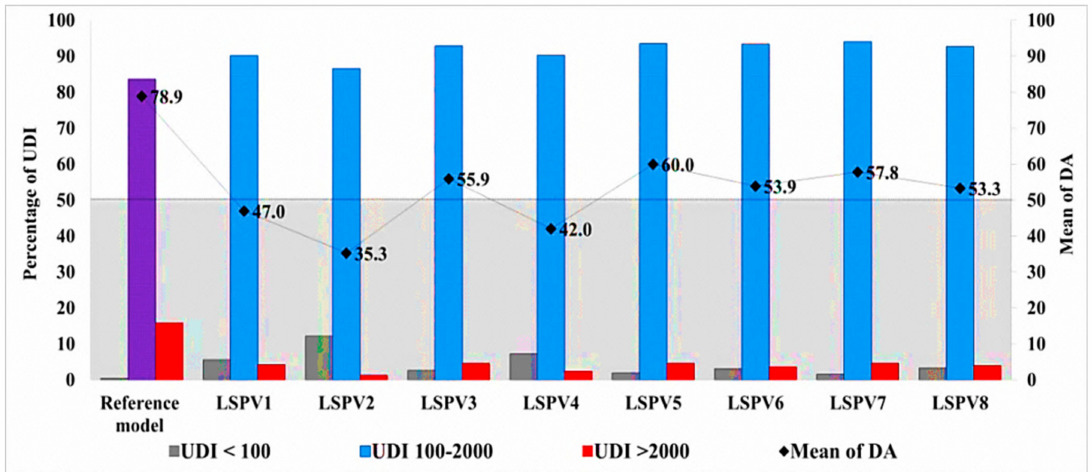
Figure 9. Annual climate-based analysis (UDI and mean of DA) of di ff erent configurations of light shelves integrated with